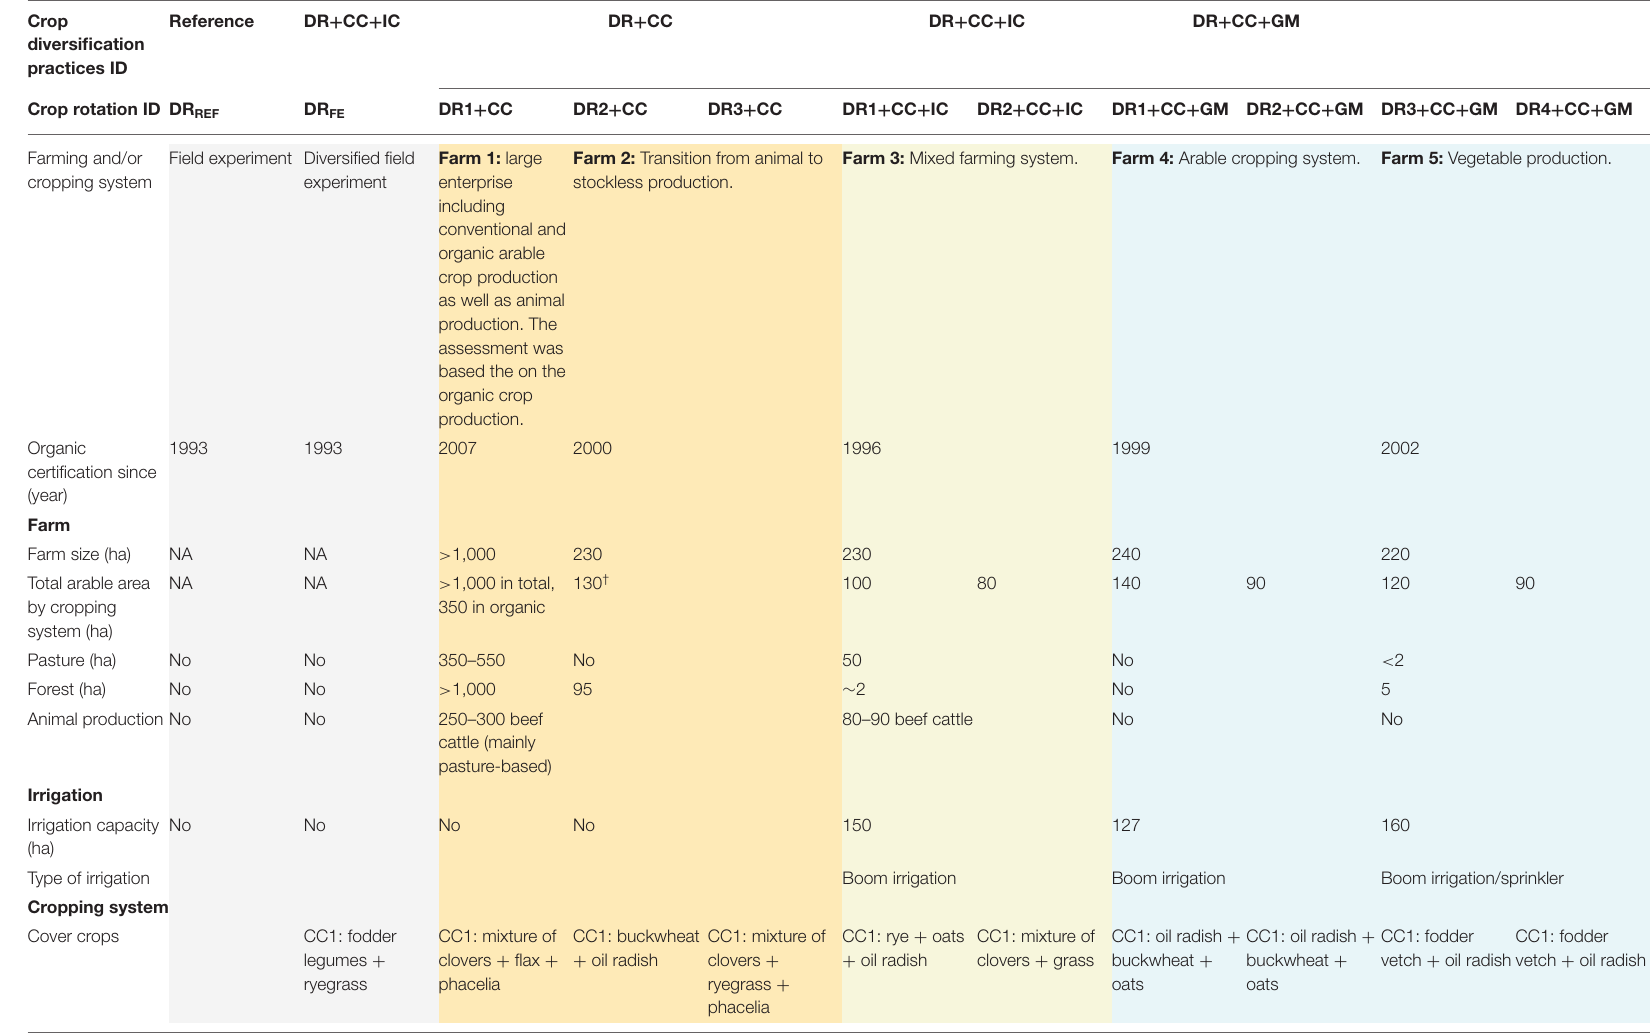
TABLE 1 | Description of the 11 cropping systems included in the analysis, based on field experiments and rotations on five commercial farms.